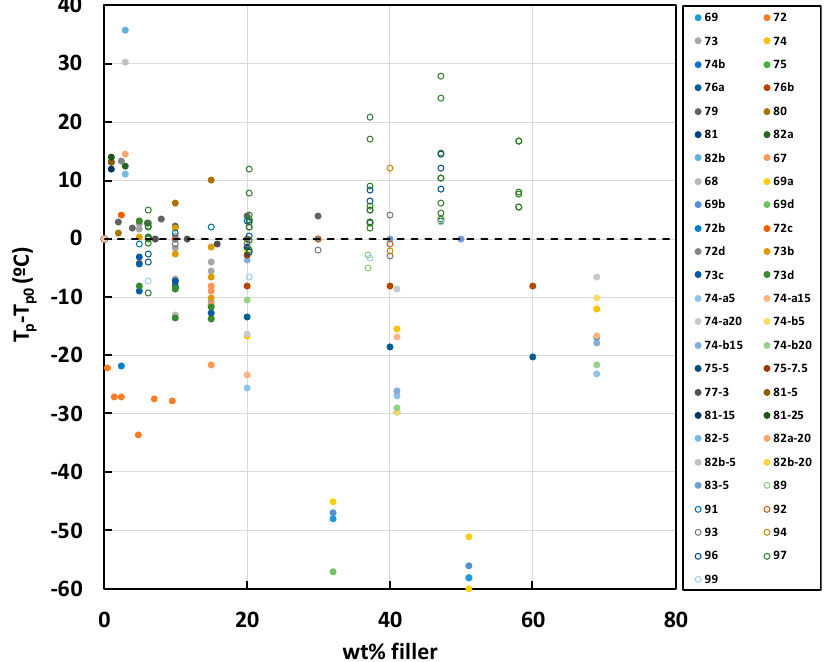
Figure 3. Effect of filler content in epoxy composites on the peak temperature, in non-isothermal cure at 10 K/min, relative to that of the unfilled system. Heating rate 10 K/min. Open symbols: boron nitride filler; filled symbols: other fillers.